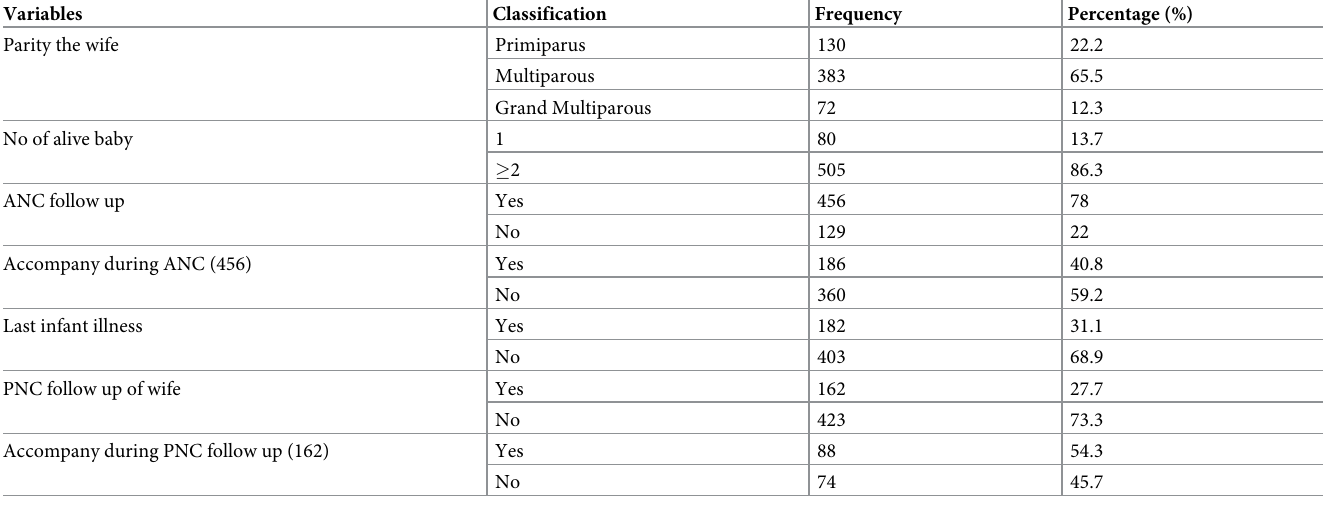
Table 2. Obstetric characteristics of wife and family size of study participants to assess knowledge towards breastfeeding in Gurage Zone, Southern Ethiopia (n = 585).